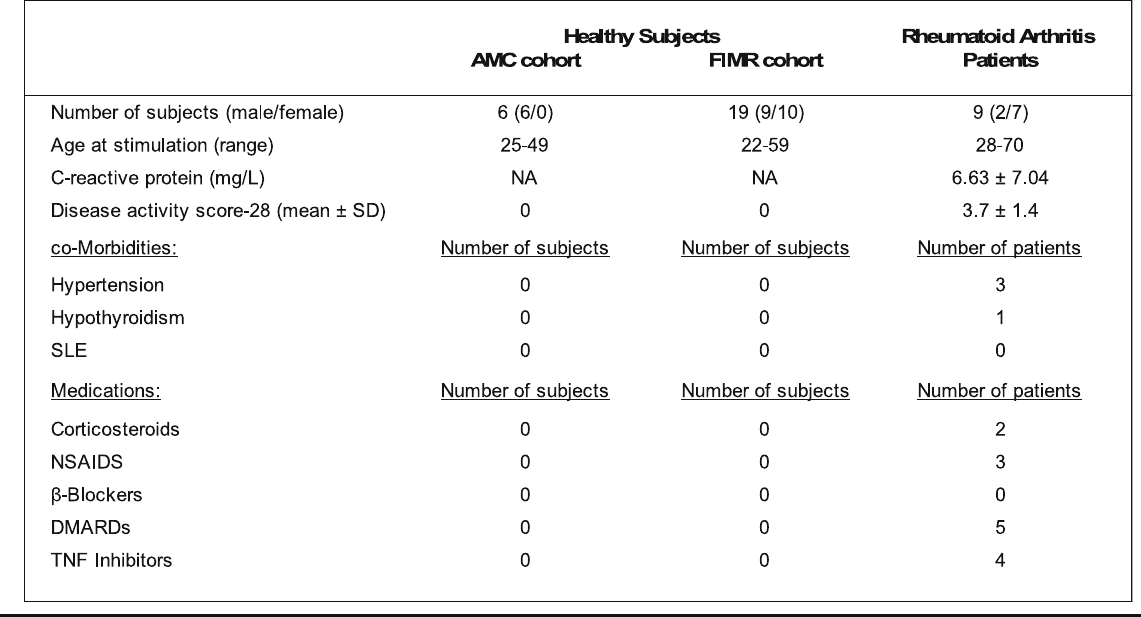
Table 1 Study participant